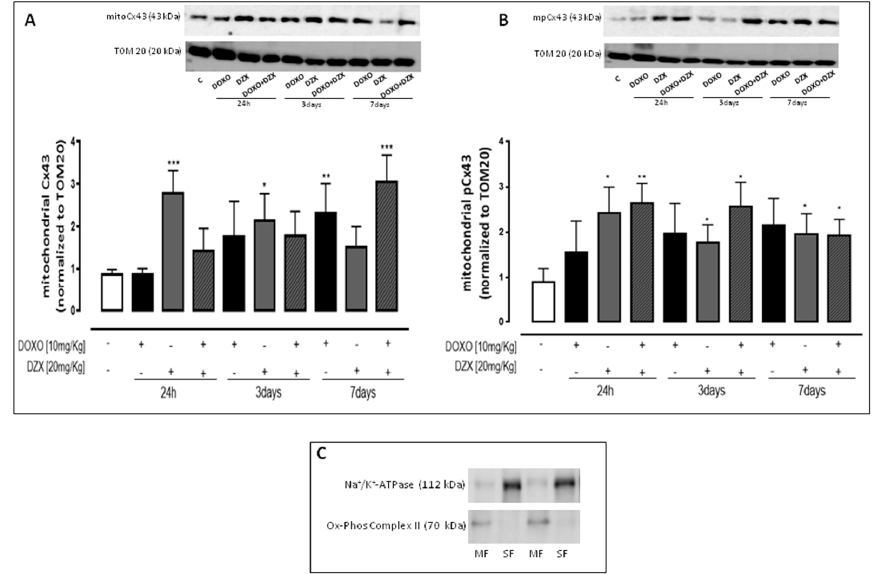
Figure 3. Effect of DOXO or DZX or combined DZX+DOXO treatment on mitochondrial amount of Cx43 ( A ) and mitoCx43 phosphorylated ( B ). Mice received a single administration (1th group), two administrations (2nd group), or three administrations (3rd group) of DOXO (10 mg/kg; i.p.)